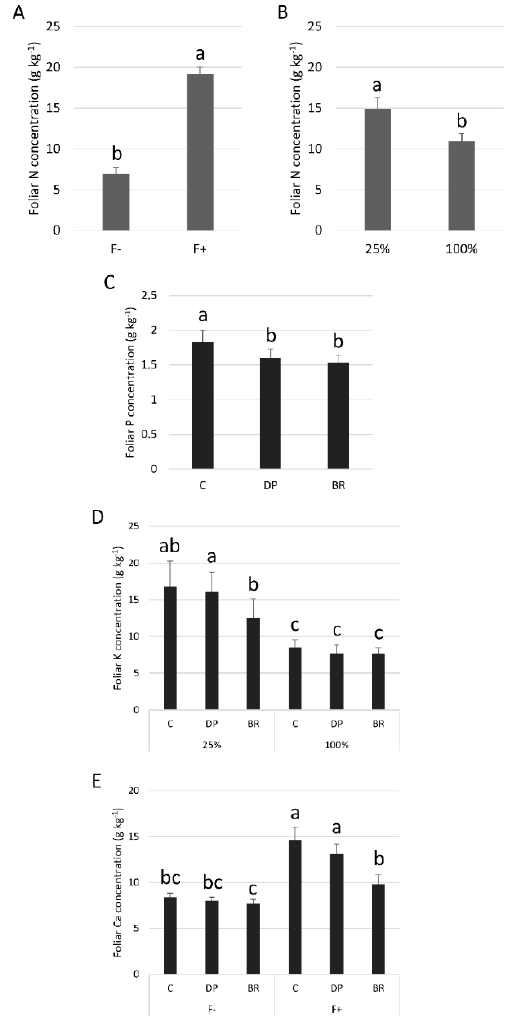
Figure 5. Mean foliar nutrient concentrations of black spruce seedlings: N, nitrogen according to ( A ) fertilization (F- without and F+ with fertilization); ( B ) irrigation (25% or 100% field capacity); ( C ) P, phosphorus according stock type; ( D ) K, potassium according stock type × irrigation; and ( E ) Ca, calcium according to stock type × fertilization. Bars with the same letter indicate a non-significant difference at P ≤ 0.05.